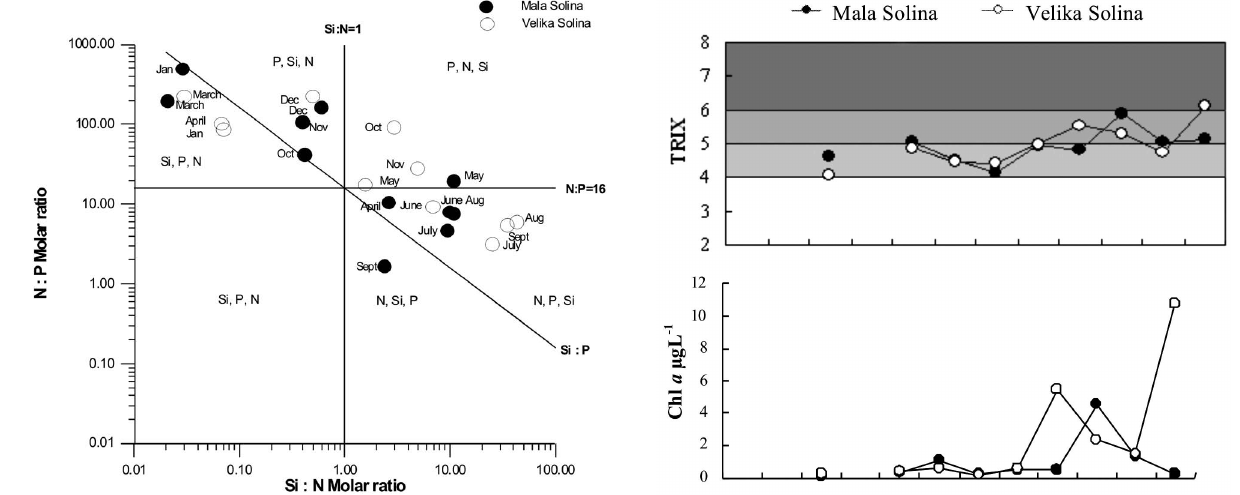
Fig . 3. – Si:N:P [ SiO : (NO +NO +NH ) : PO molar ratios in 4 3 2 4 4 ] Mala Solina and Velika Solina. Molar quotients between in situ con- centrations of potentially limiting nutrients are delimited by Si:N = 1, N:P = 16, and Si:P = 16 lines. Lines define six different areas Fig . 4. – Chlorophyll a concentration (Chl a ) and TRIX units within the plot, each characterized by a potentially limiting nutrient (0-4 oligotrophic, 4-5 mesotrophic, 5-6 eutrophic, 6-10 extremely in order of priority (Rocha et al., 2002). eutrophic) in Mala Solina and Velika Solina during the 1-year